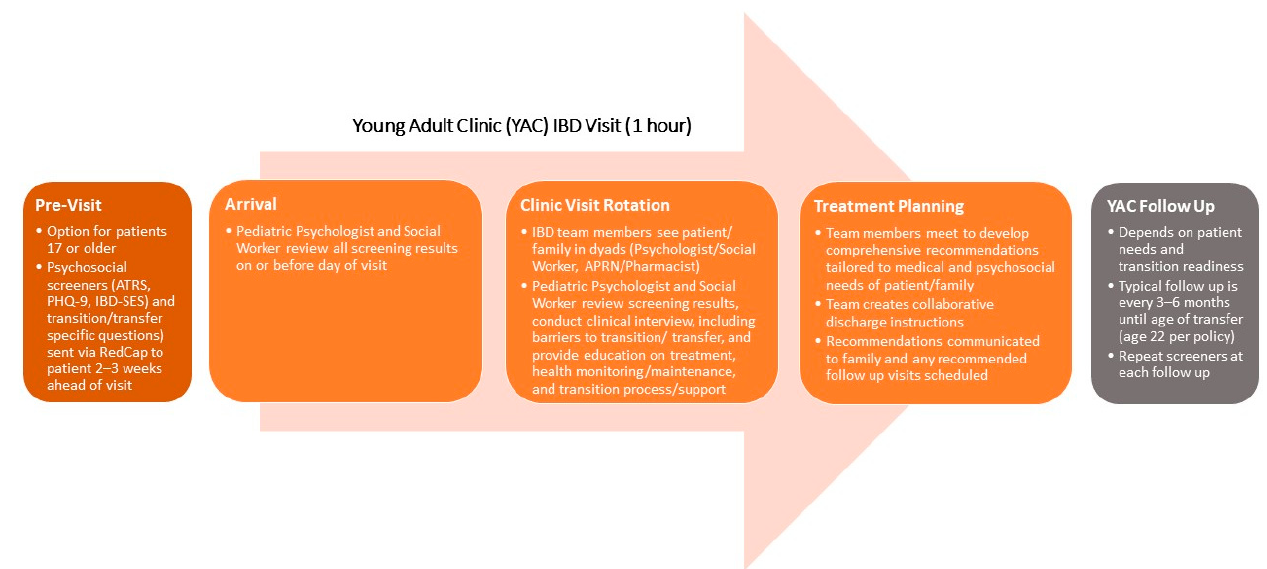
Figure 2. Sample flow diagram with inclusion of screening process for young adult integrated care clinic for pediatric IBD. Screening measures referenced above: ATR, Allocation of Treatment Responsibility Scale [28]; PHQ-9, Patient Health Questionnaire-9 [29]; IBD-SES, IBD Self-Efficacy Scale [30]. For more information on this clinic and the screening pro- cess/questions used, please see Maddux and colleagues [31].